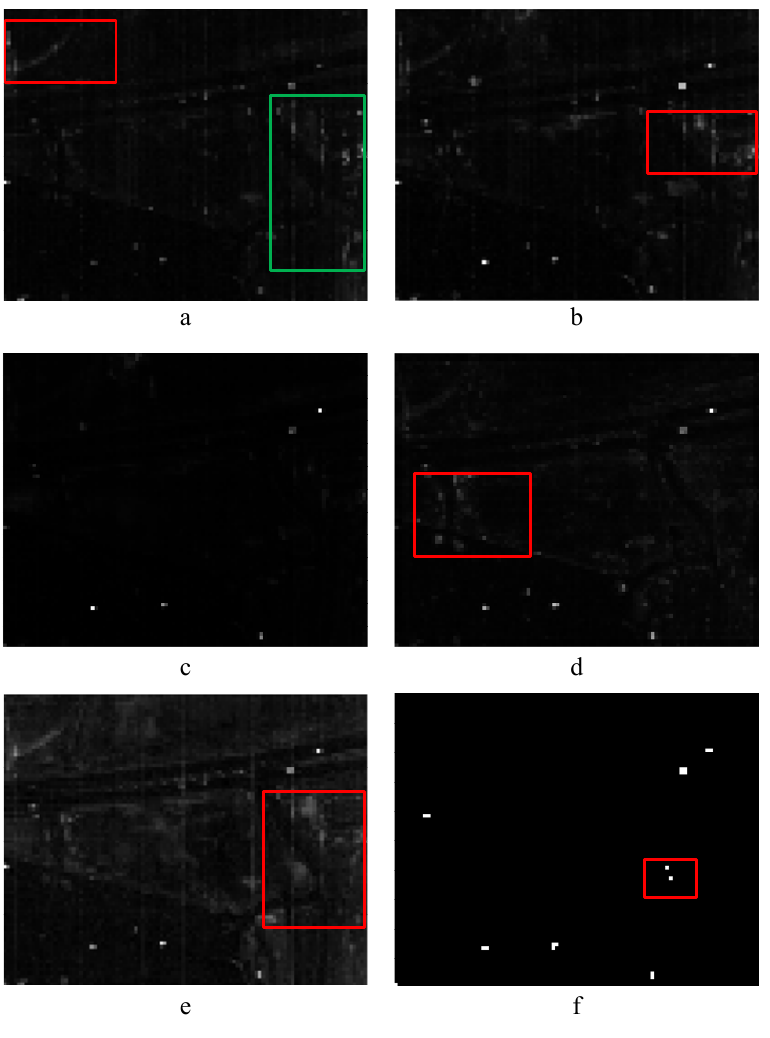
Figure 6. Detection results of ( a ) GRX, ( b ) FEE, ( c ) FEBPAD, ( d ) LSAD-CR-IDW, ( e ) LRSRD, and ( f ) Triple-S for HYDICE Urban data set.